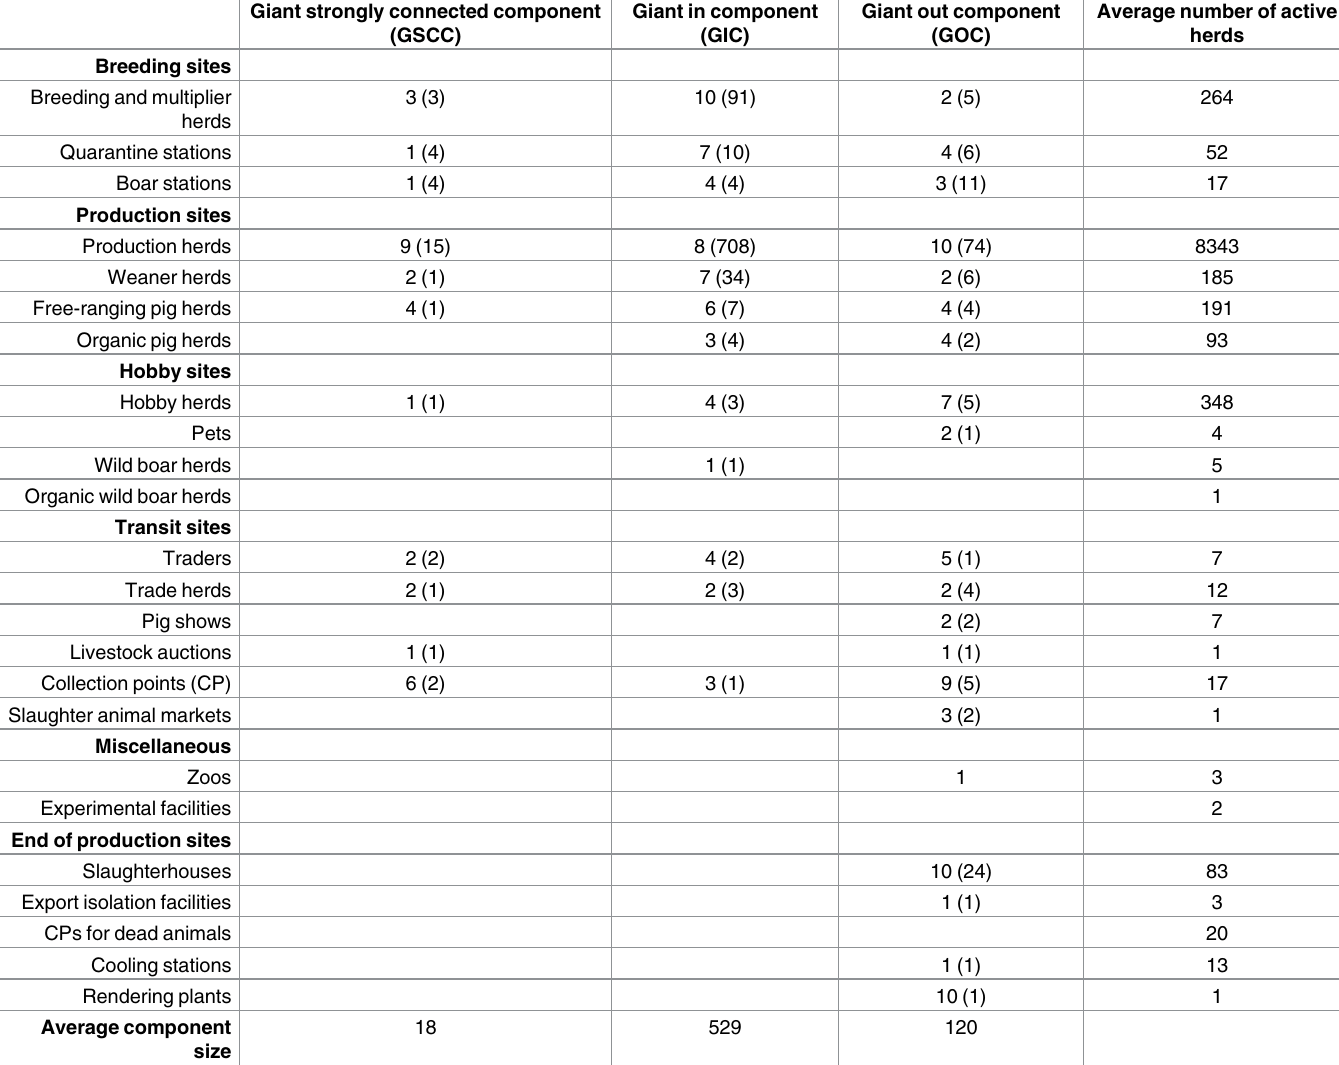
Table 3. Number of years between 2006and 2015, in which the holding type is present in the pig movement network components. Giant strongly connected component